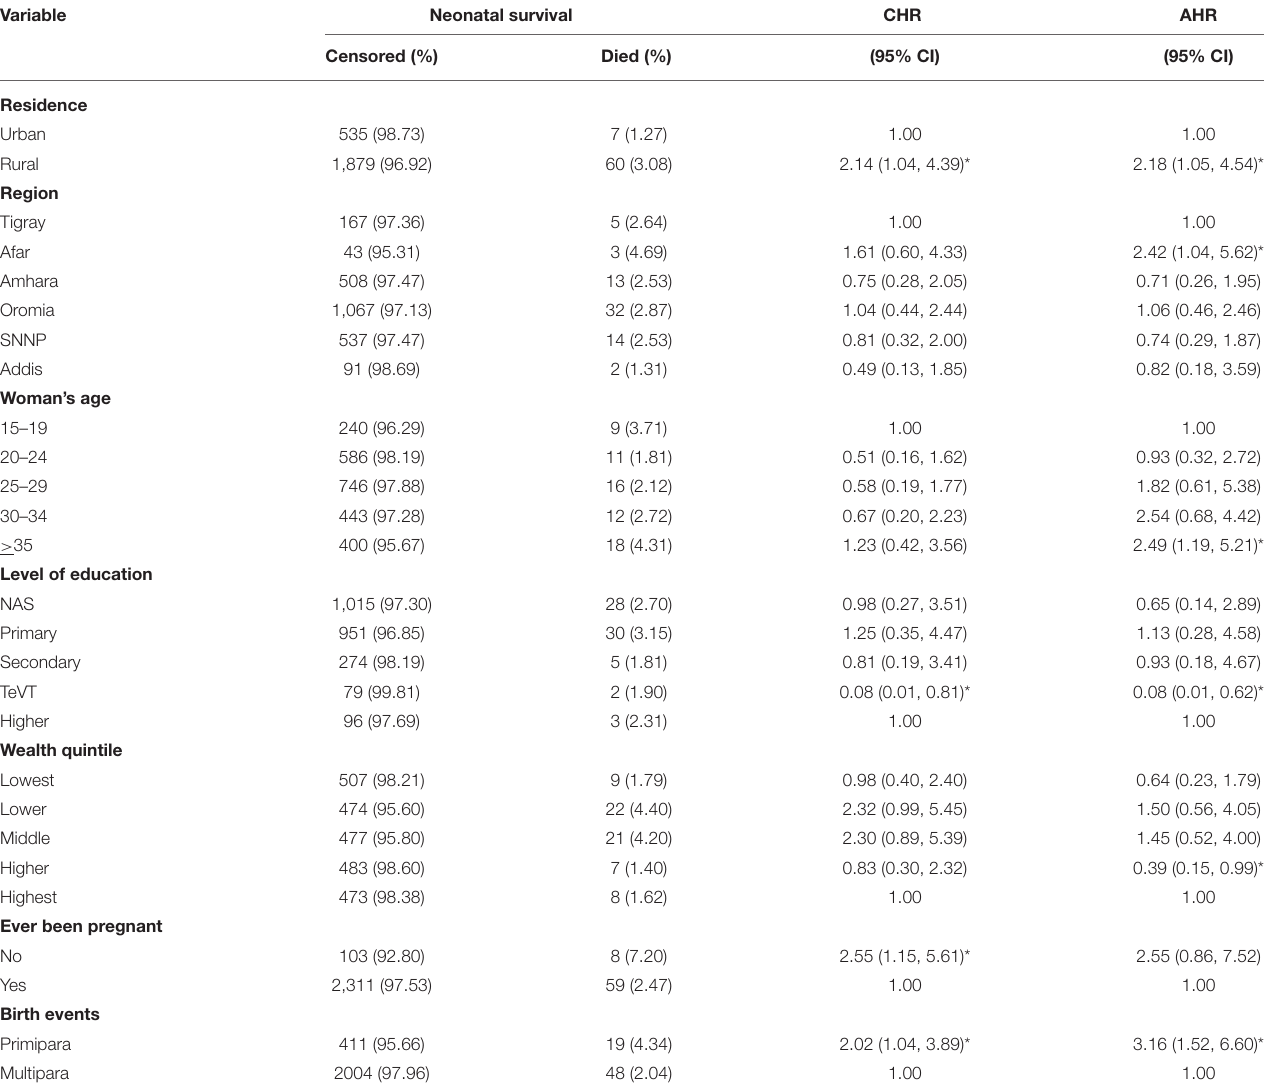
TABLE 3 | Multivariable Cox proportional hazard regression analysis of predictors of neonatal mortality in Ethiopia, October 2019 to September 2020 ( n = 2,481).